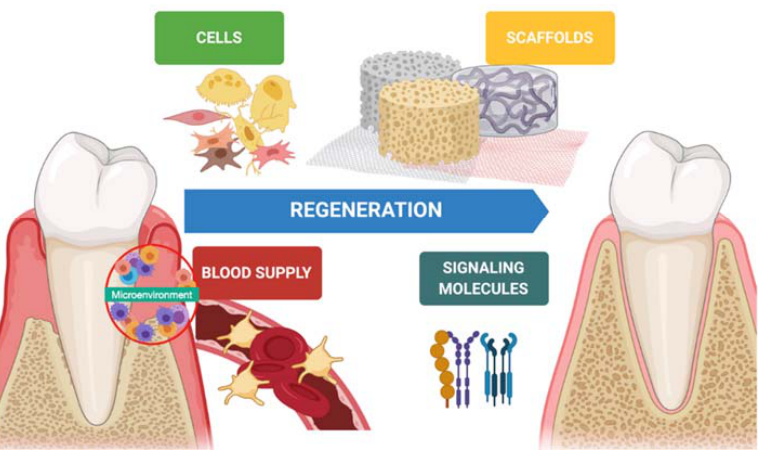
Figure 1. Iconographic representation of the factors involved in periodontal regeneration.